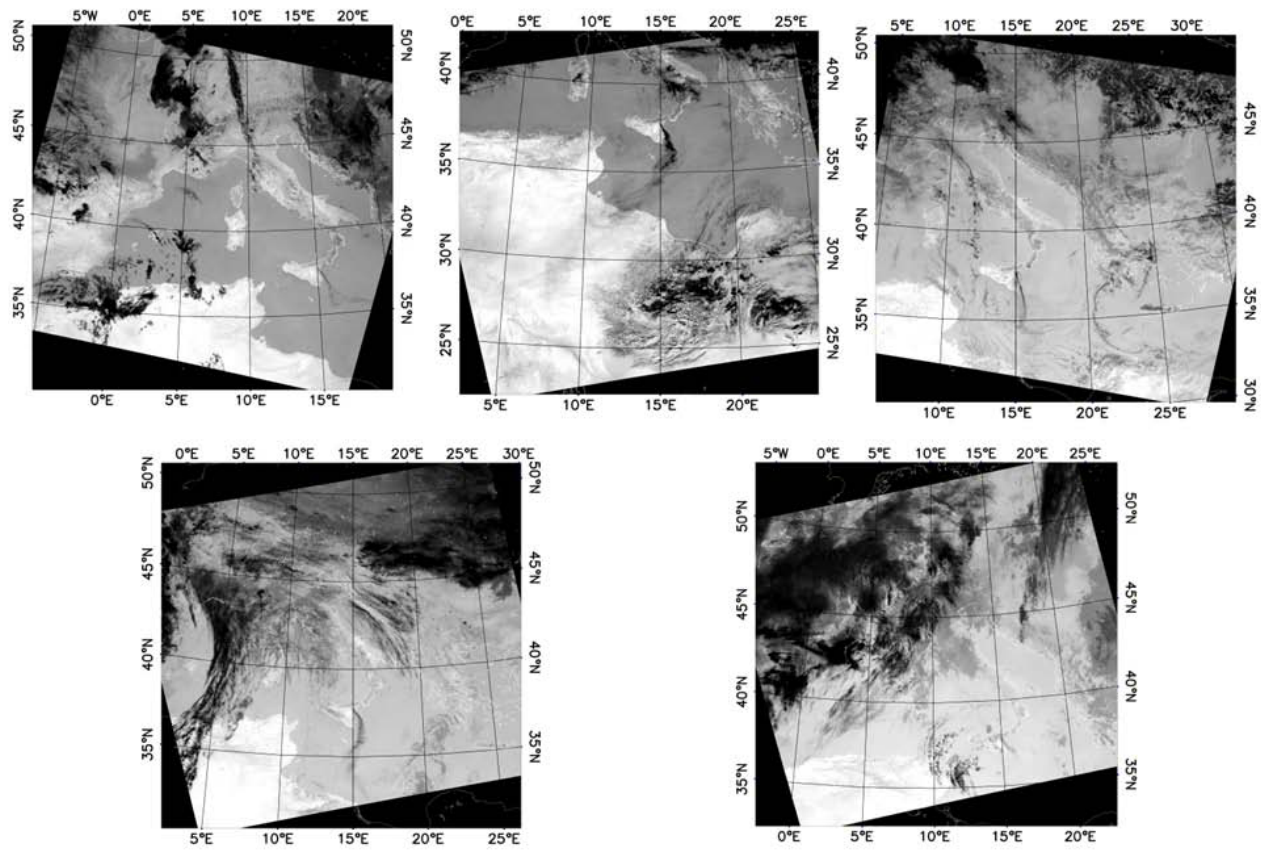
Fig. 1. Channel 31 MODIS test case images. Top Plates, from left to right: 23 July 2001 at 10:35UTC; 28 October 2001 at 12:15UTC and 29 October 2002 at 12:05UTC. Bottom Plates, from left to right: 30 October 2002 at 9:45UTC and 24 November 2006 at